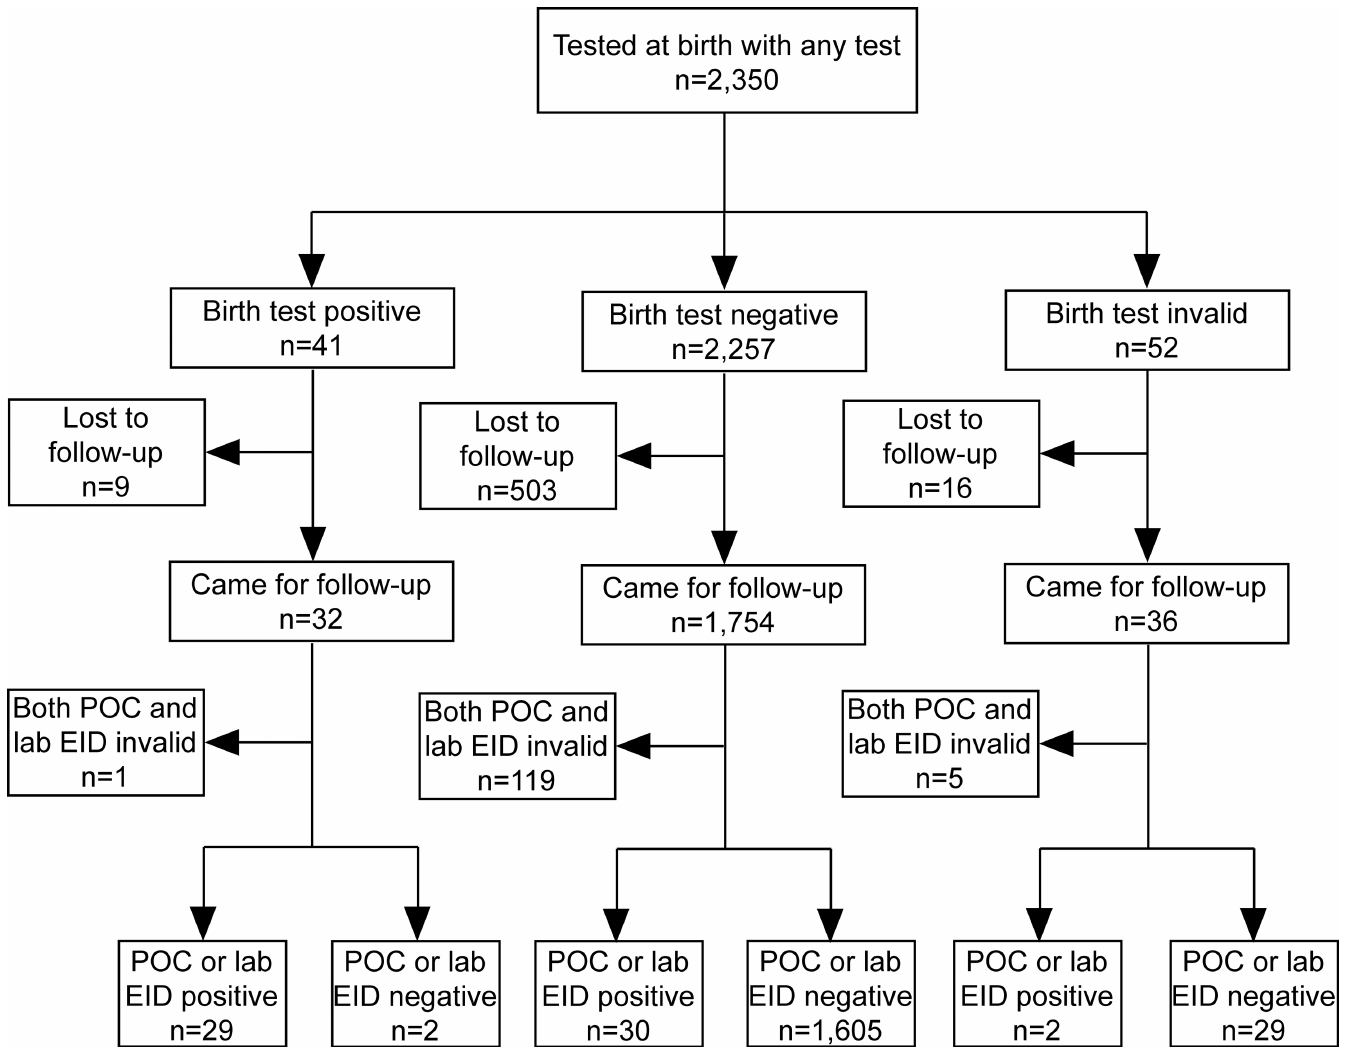
Fig 2. Flow diagram of participants at birth and at routine EID testing time point. Lost to follow up = patients tested at birth but who did not attend routine early infant diagnosis consultation, POC = Point of Care, EID = Early Infant Diagnosis, Lab = laboratory test.